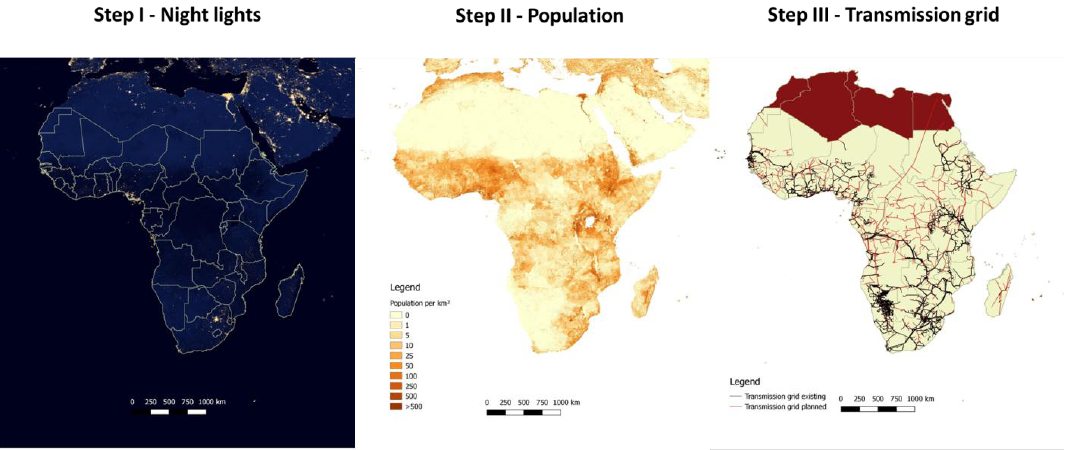
Figure 2. Visualised data used for geospatially resolved analyses structured in step I (night lights), step II (population) and step III (transmission grid).